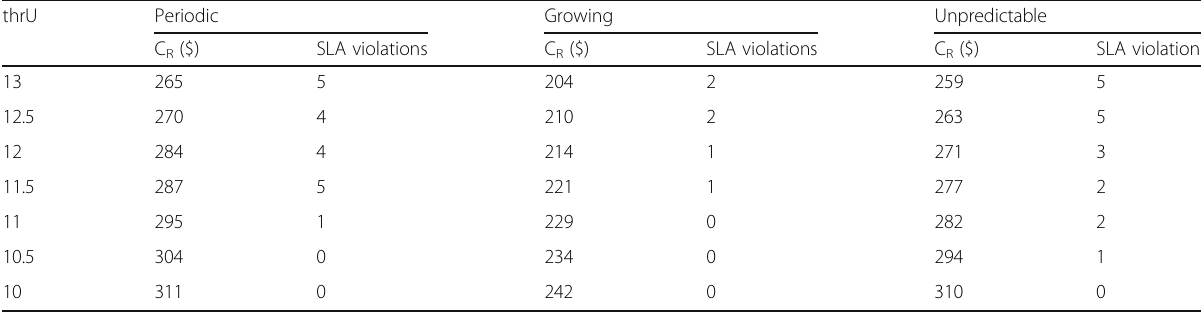
Table 6 Impact of decreasing thrU on the cost